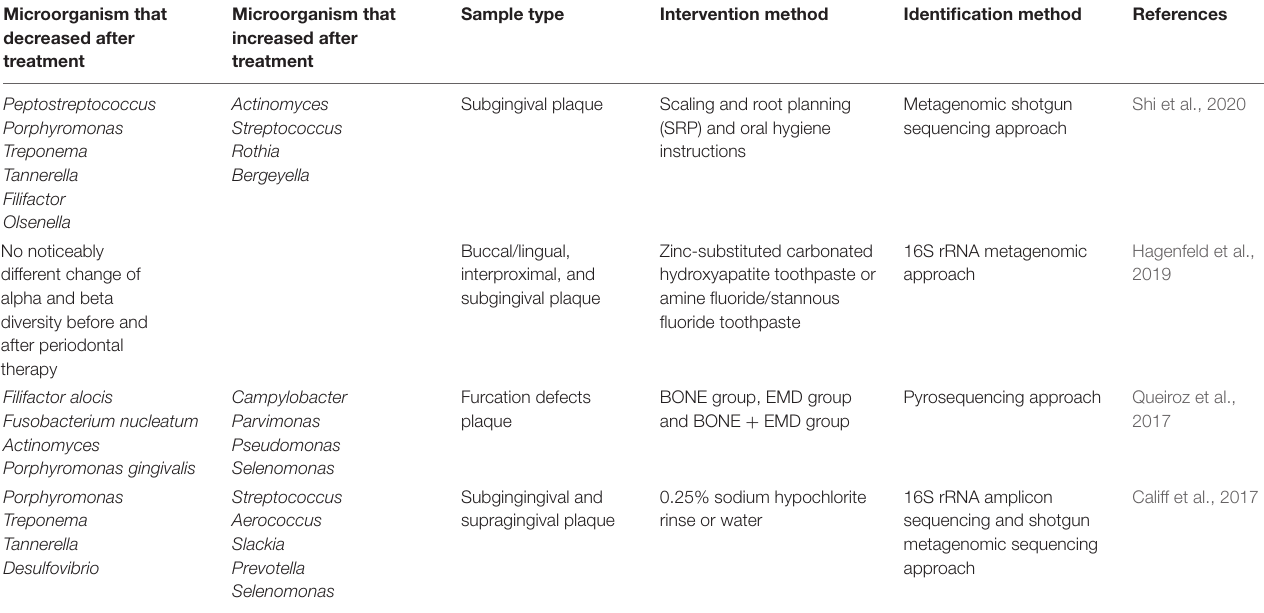
TABLE 2 | Detecting the alteration of periodontitis related pathogens before and after treatment with metagenomics and